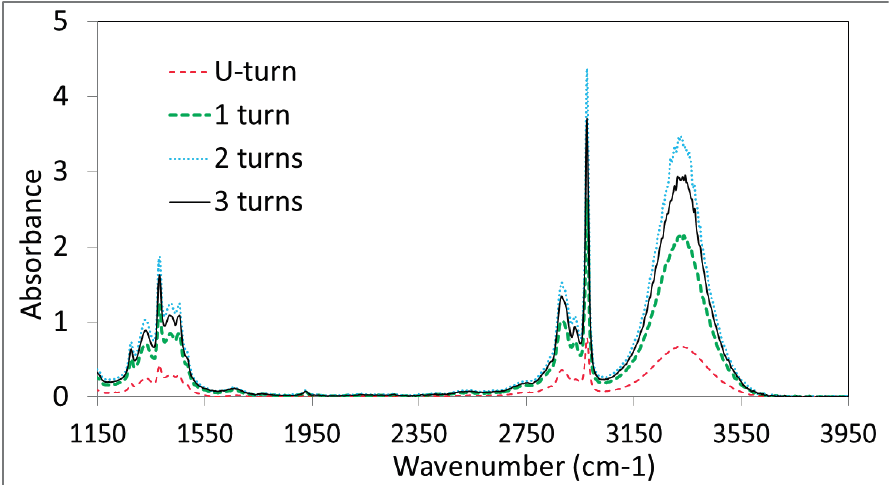
Figure 5. Evolution of the sensitivity (still with an alcoholic solution) with the number loops of the sensing head: a single U-turn, one, two and three full loops or